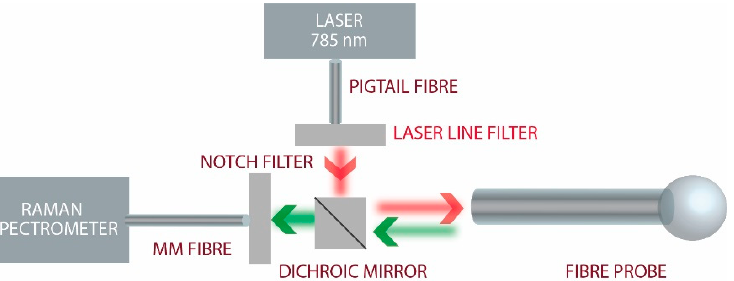
Figure 2. Experimental setup where light from a 785 nm laser is coupled to the NCF fibre probe using a dichroic mirror and collected Raman-shifted wavelengths are measured with a Raman spectrometer.